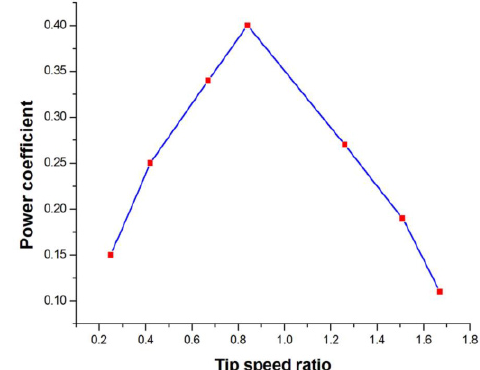
Figure 5. Extracted power coefficient variation with tip speed ratios at ambient water speed of 2.5